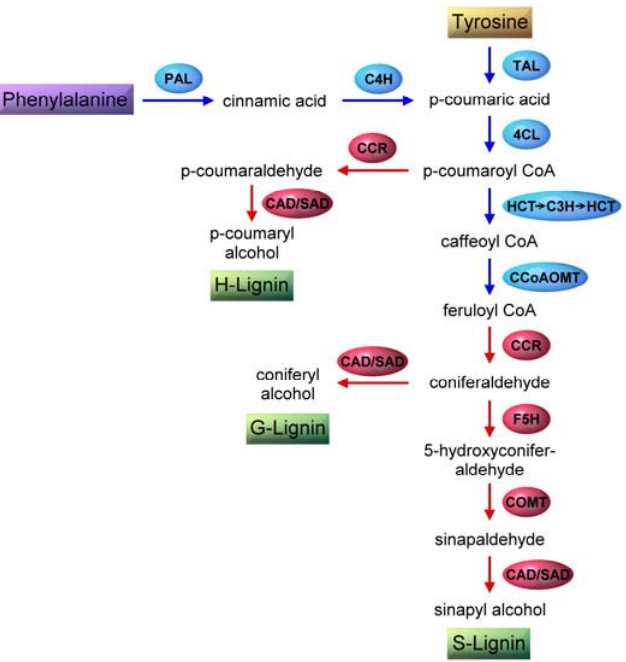
Figure 3. Outline of enzymes/pathways involved in monolignol biosynthesis. Enzymes are enclosed in ellipses while substrates and products are boxed. Phenylpropanoid pathway is shown in blue and monolignols biosynthesis in red. Arrows indicate sequential enzymatic steps. Abbreviations are (order of appearance): PAL, phenylalanine ammonia lyase;